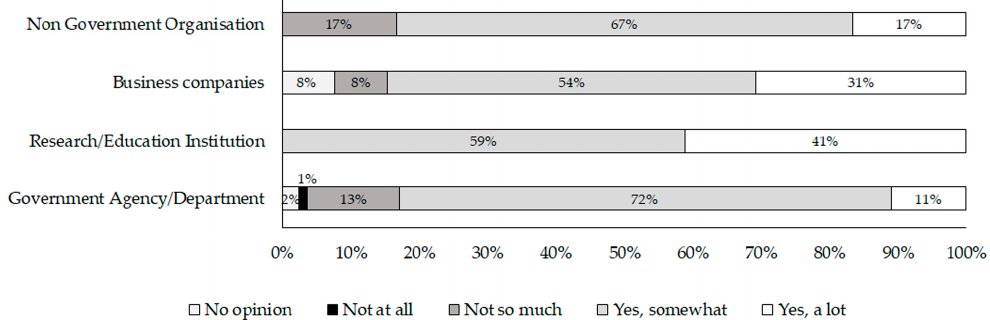
Figure 1. Percentage of respondents for each Likert scale point (No opinion, Not at all, Not so much, Yes, somewhat, Yes a lot) regarding the feeling of being up to date on the newest scientific findings ( n = 137). Statistical differences are reported within the text.